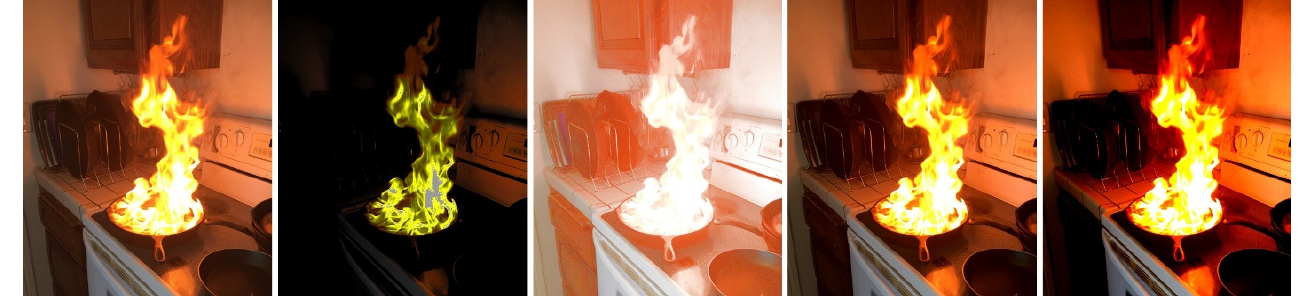
Figure 7. Example of fire images after contrast and brightness adjustment.